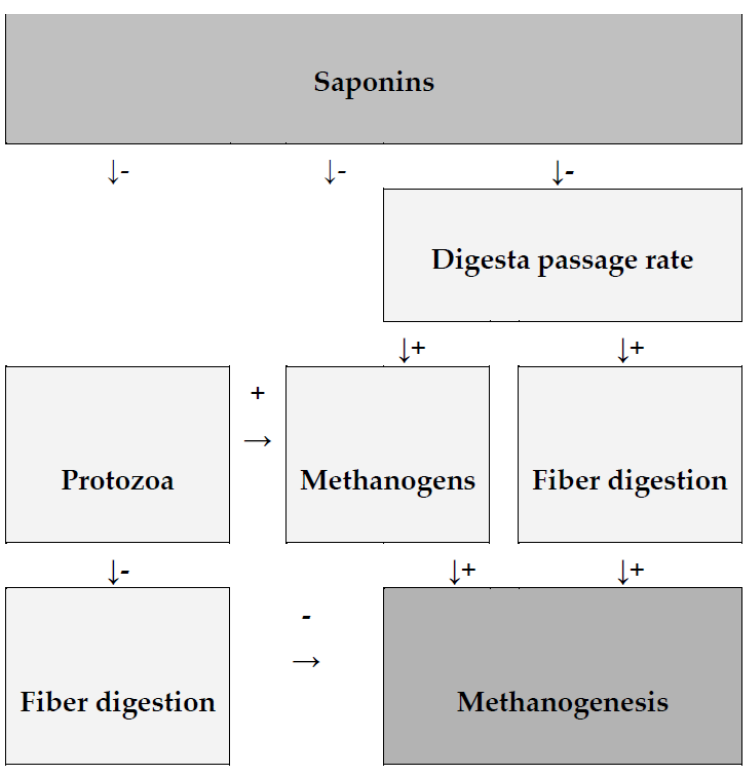
Figure 2. Diagram shows the impact of saponins on methanogenesis as well as the effects of secondary rumen fermentation modification. (+) increase; ( − ) decrease, according to Patra and Saxena [62].